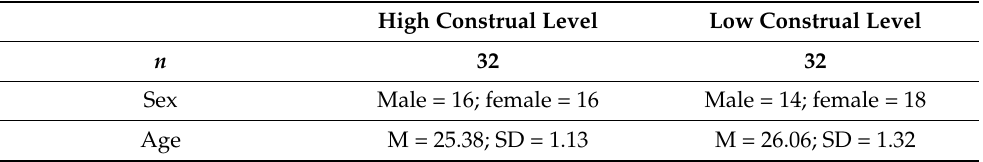
Table 2. Demographic information of high construal level group and low construal level